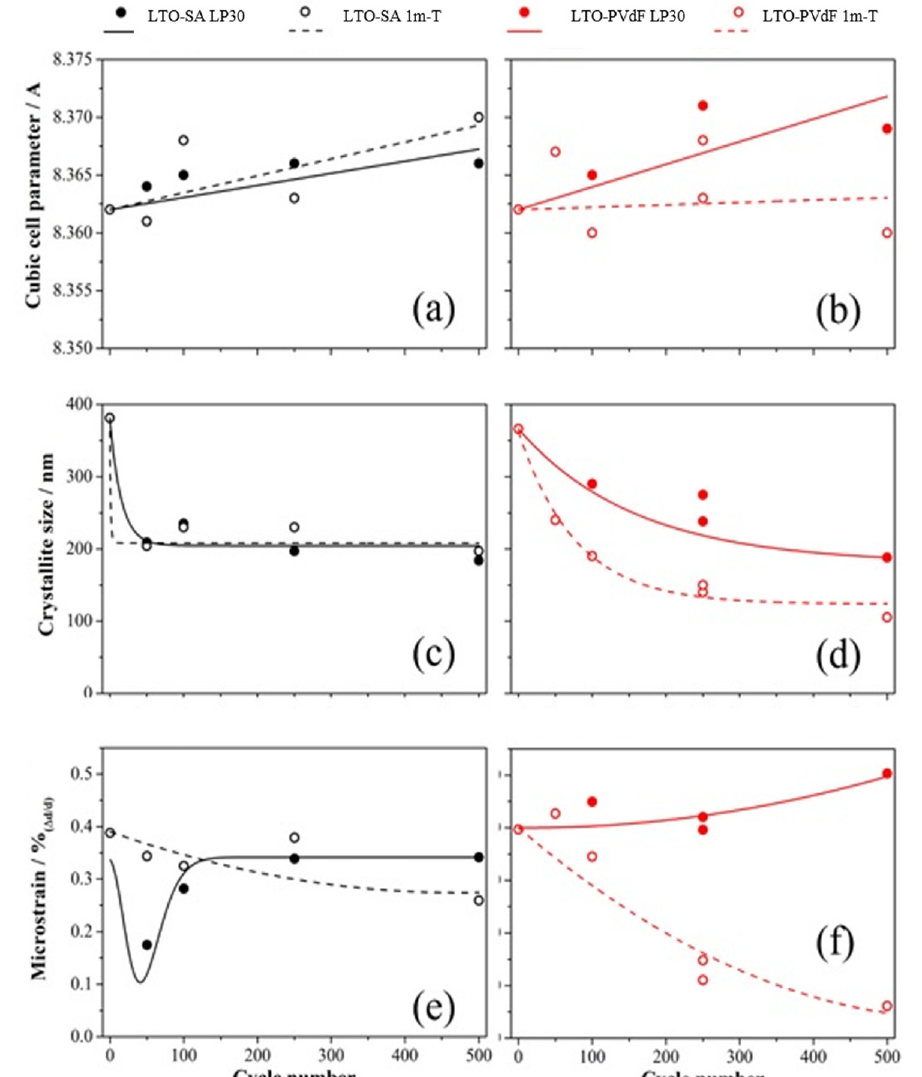
Figure 5. Relevant structural features (cubic cell parameter, crystallite size, and microstrain) for pristine and ex situ samples derived from the Rietveld refinements of the corresponding synchrotron XRD patterns: ( a , c , e ) LTO-SA (black symbol) and ( b , d , f ) LTO-PVdF (red symbol) electrodes tested in LP30 (full symbol) and 1m-T (empty symbol). Solid and dashed lines represent a simple guide for the eye.